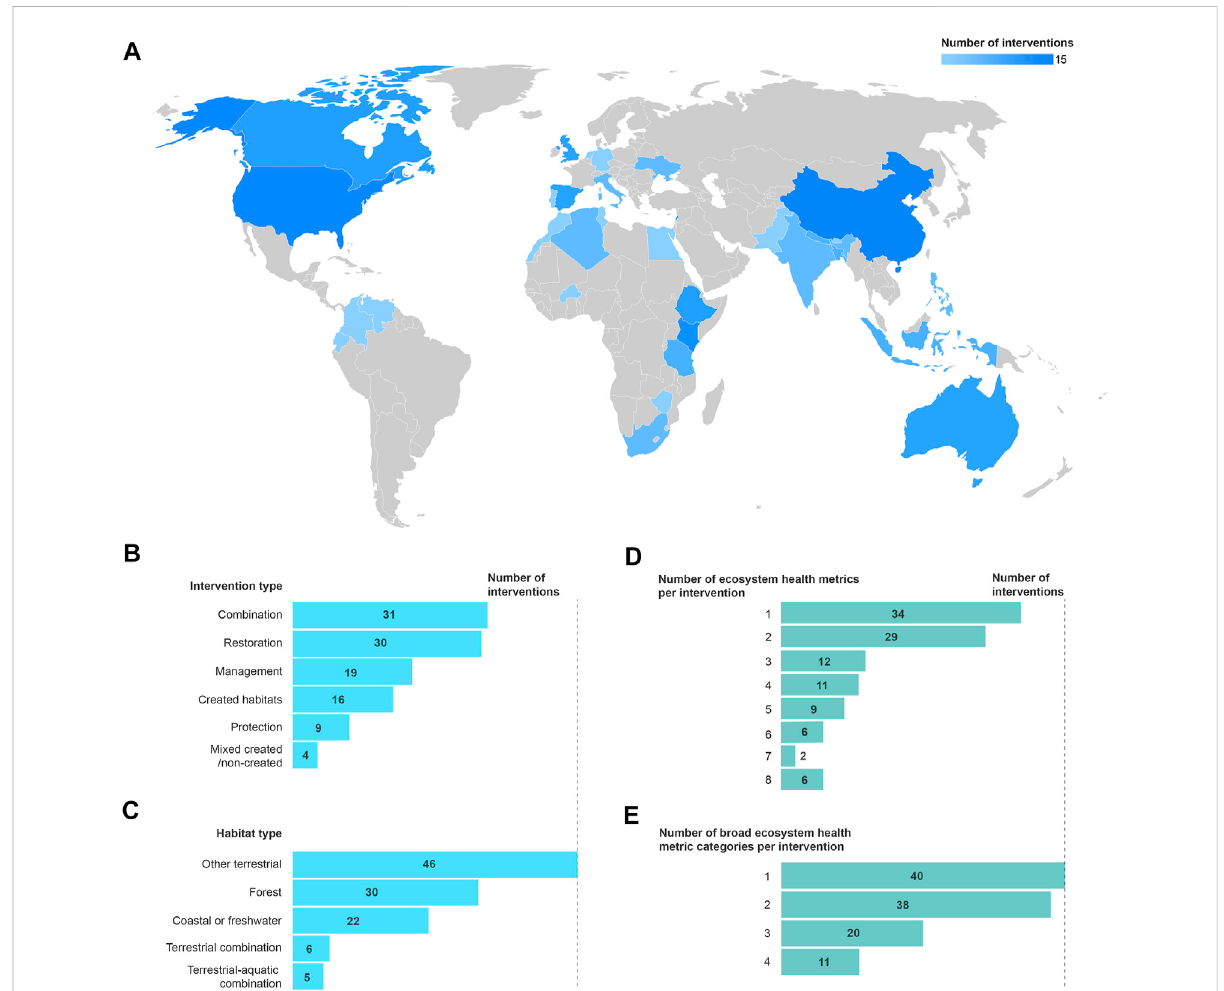
FIGURE 1 Global distribution of nature-based interventions identi fi ed in this study (A) , number of interventions of each broad type of NbS (B) , number of interventions in each habitat type (C) , number of unique ecosystem health metrics per intervention (D) , and number of unique broad ecosystem health metric categories per intervention (E)